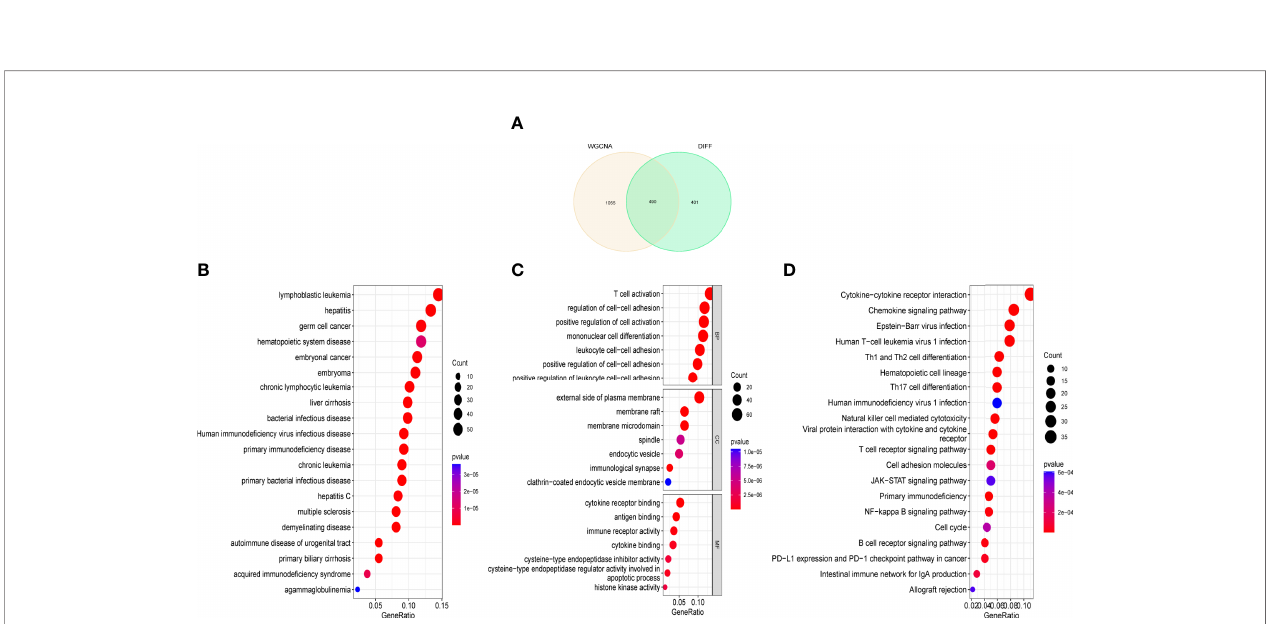
FIGURE 3 | Functional analysis of key module genes merged with DEGs. (A) Venn diagram of key module genes versus DEGs. (B) DO analysis. (C) GO analysis. (D) KEGG analysis.